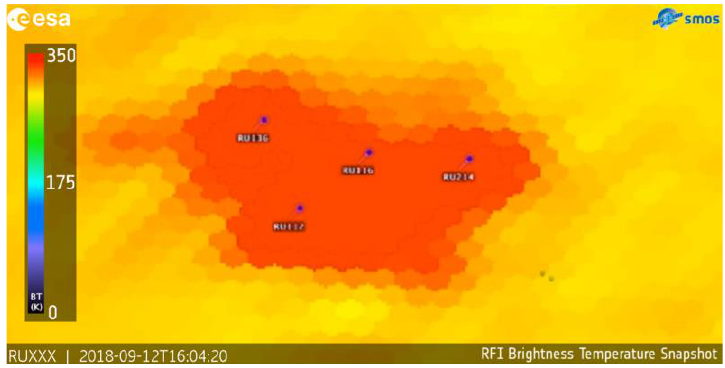
Figure 20. SMOS brightness temperature map over Moscow.